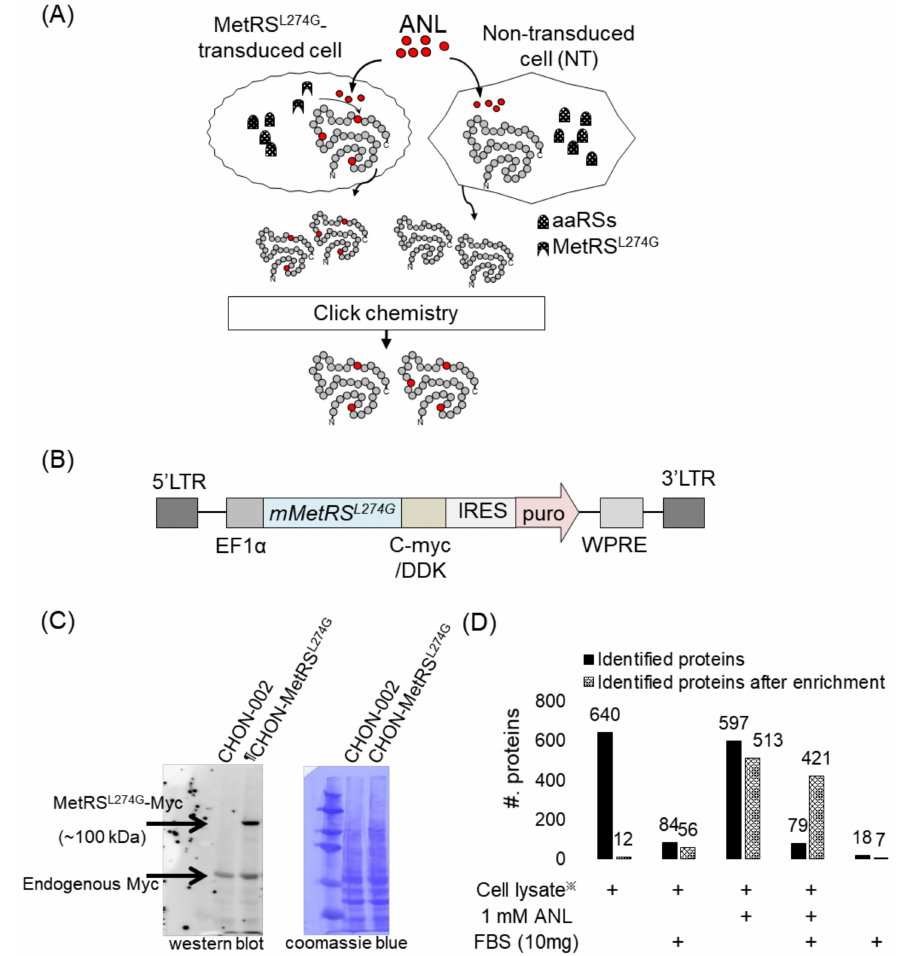
Figure 1. Labeling of a newly synthesized protein with ANL using a mutant mouse MetRS (MetRS L274G )-expressing cell line. ( A ) Our strategy is to label a newly synthesized protein in a specific cell that is co-cultured with another type of cell. The specific cell whose secretome is of interest is transduced to express a mouse MetRS variant (MetRS L274G ) capable of ANL incorporation during protein synthesis. ( B ) Structure of the lentiviral vector used to express the mutant mouse MetRS L274G gene. LTR: ; long terminal repeat; EF1 α : elongation factor 1 alpha; mMetRS L274G : mouse mutant MetRS gene; DDK: FLAG tag; IRES: internal ribosome entry site; puro: puromycin resistance gene; WPRE: WHP posttranscriptional regulatory element. ( C ) Expression of MetRS L274G in the transduced cell. The expression of MetRS L274G is confirmed using an anti-Myc antibody in a western blot with mutant MetRS tagged with Myc at its N-terminus (left). The protein expression pattern in the transduced cell line does not differ from the one in wild-type cells according to Commassie blue staining (right). ( D ) Verification of our enrichment strategy. The lysate of MetRS L274G -expressing cell, which is either treated with ANL or not treated, is processed by click chemistry-based enrichment, and the number of identified proteins is indicated. FBS-derived proteins are used as background interference. ※ : MetRS L274G transduced CHON-002 cell